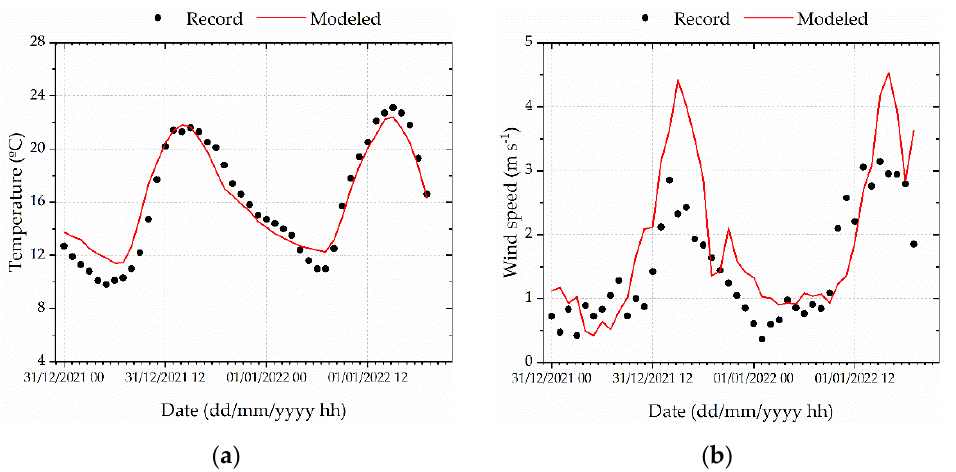
Figure A1. Hourly meteorological records versus modeled values on 31 December 2021 and 1 January 2022 (MUN station): ( a ) temperature and ( b ) wind speed.